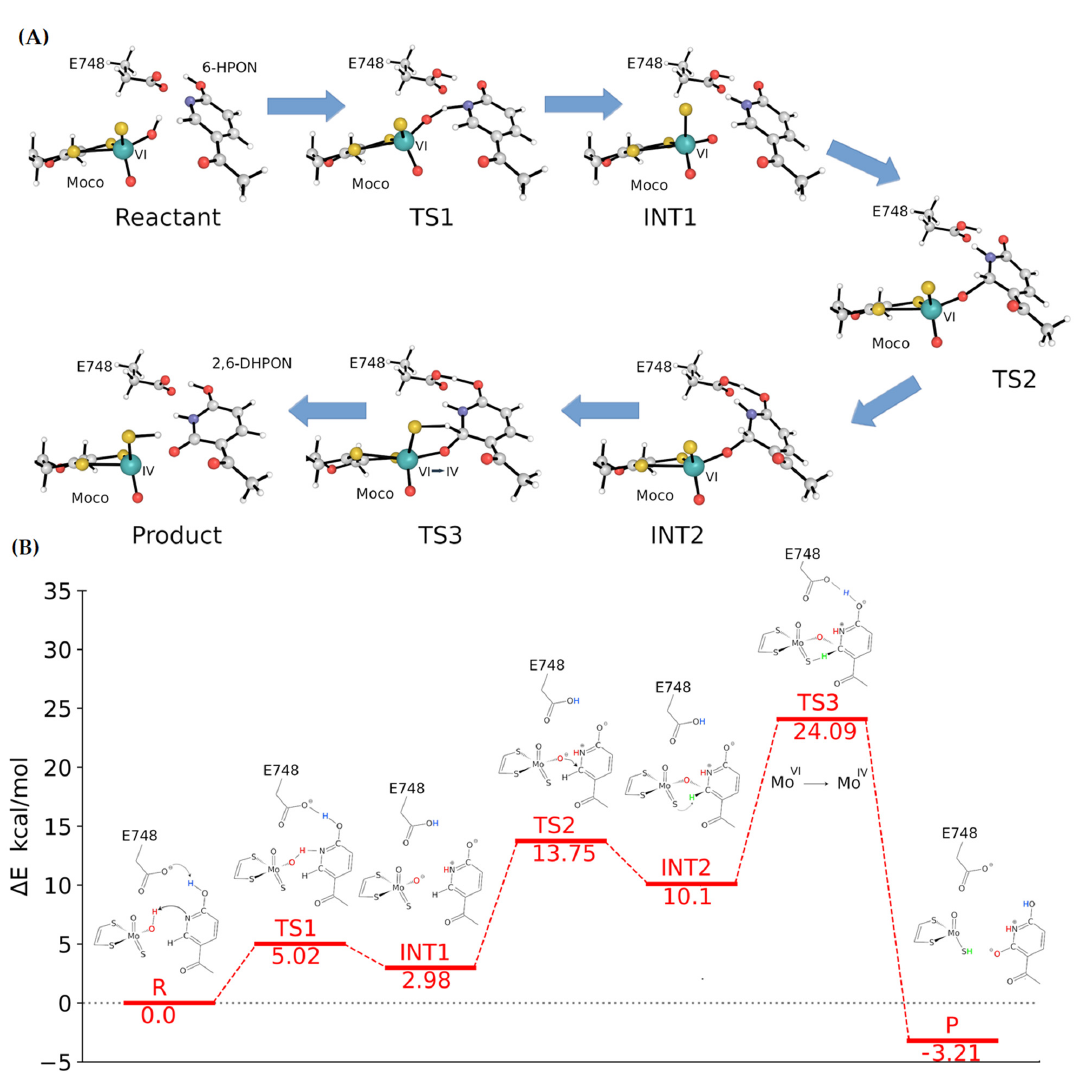
Figure 6. Reaction mechanism and free energy profile of Kdh-catalyzed reaction. ( A ) Our proposed reaction mechanism of Kdh-catalyzed oxidation 6-HPON, with KdhL-E748 playing an important role in the reaction. ( B ) Free energy profile of the oxidation of 6-HPON to 2,6-DHPON. This reaction consists of 3 sequential stages which are initialized by a proton transfer from Table 1. nitrogen atom of 6-HPON. The first process is also accompanied by a concerted proton transfer from the hydroxyl group of 6-HPON to the carboxylate group of E748, which maintains the charge balance of the substrate, supporting the hypothesis that E748 is involved in the catalytic process as a general base. The final step is the rate-limiting step of the whole catalytic process with an activation energy of 24.09 kcal/mol, corresponding to the hydride transfer from the pyridine C2 carbon atom in the tetrahedral geometry to the sulfur S1 of the MCD.